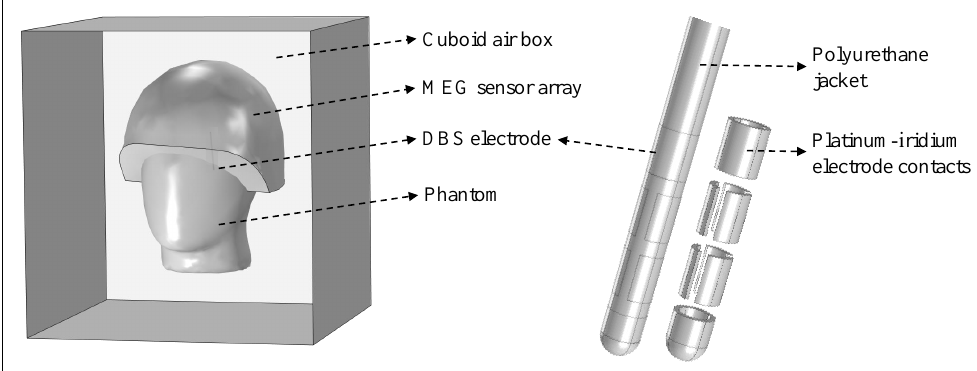
Figure 8. Finite element electromagnetic model. It includes the phantom filled with saline solution, the directional electrode placed inside the phantom, and the helmet-shaped MEG sensor surface. These structures are surrounded by a cuboid air box.